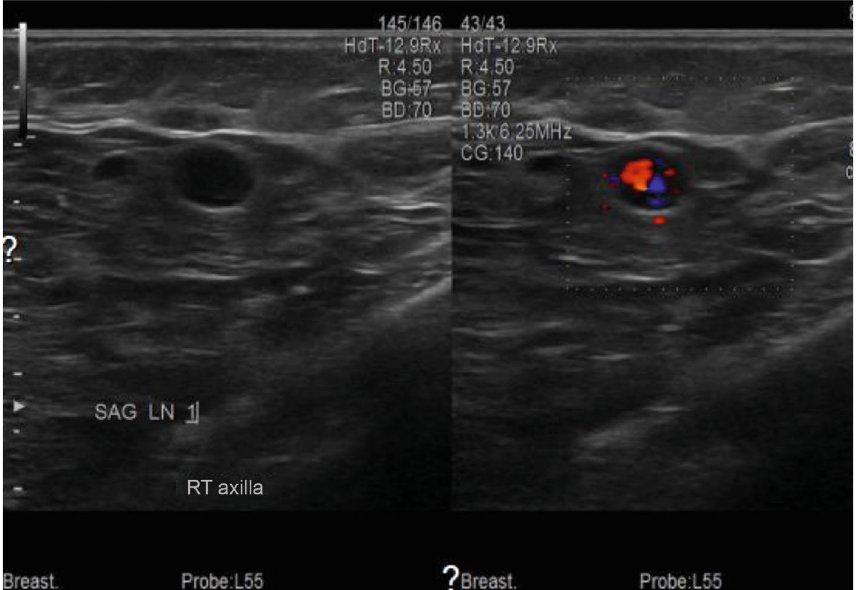
Figure 2: Suspicious axillary lymphadenopathy with aberrant blood fl ow.